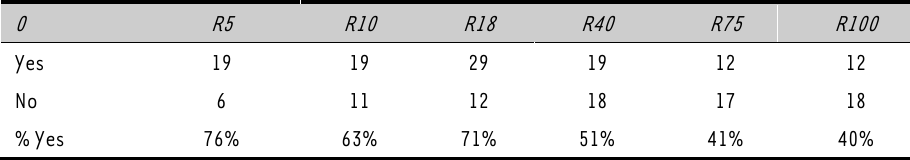
Bid responses at each bid amount and probabilities of a ‘yes’